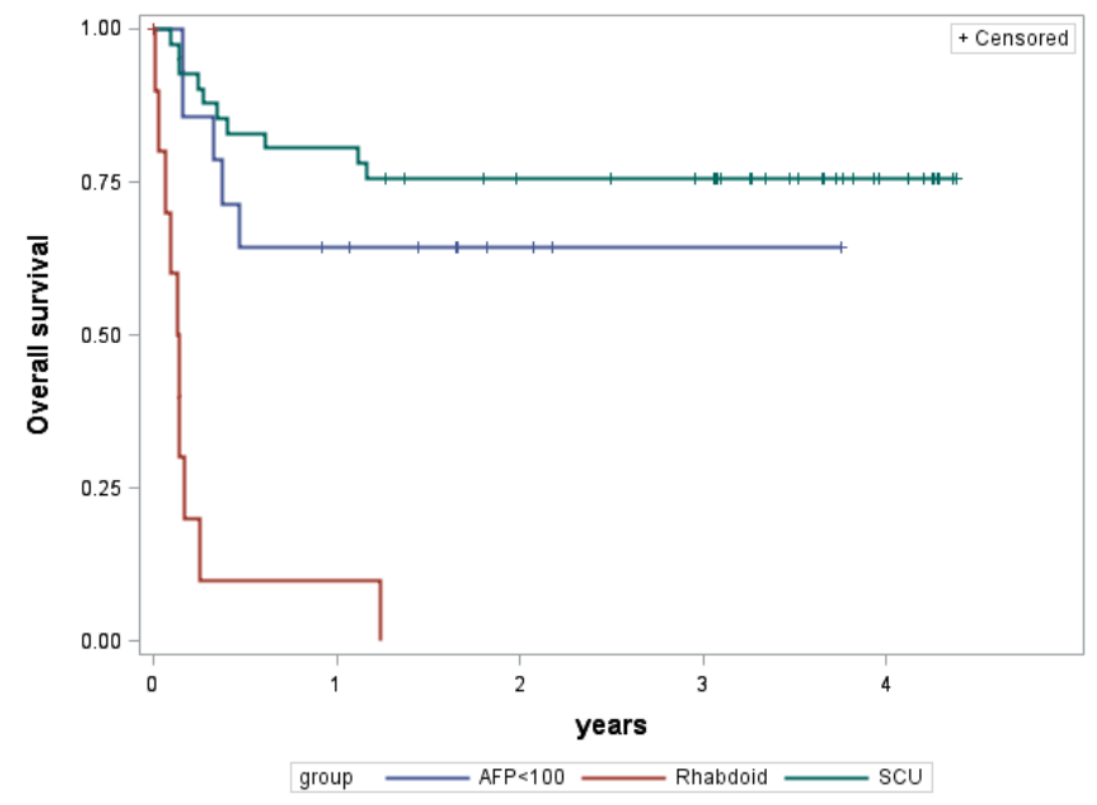
Figure 3. Overall survival in years by group. AFP, alpha-fetoprotein; HB, hepatoblastoma.